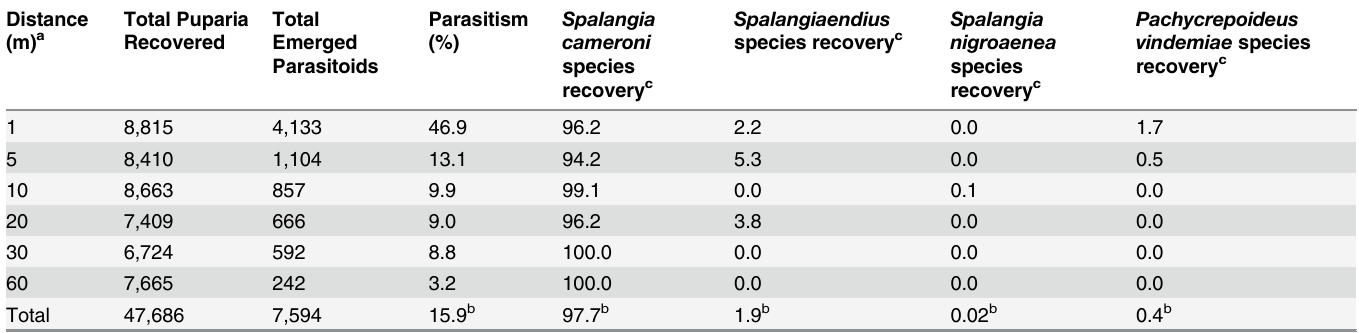
Table 1. Recovery of house fly puparia, percentage parasitism, and parasitoid species at distances of 1 to 60 m from points of mass-release with female Spalangia cameroni Total Puparia Distance (m) a